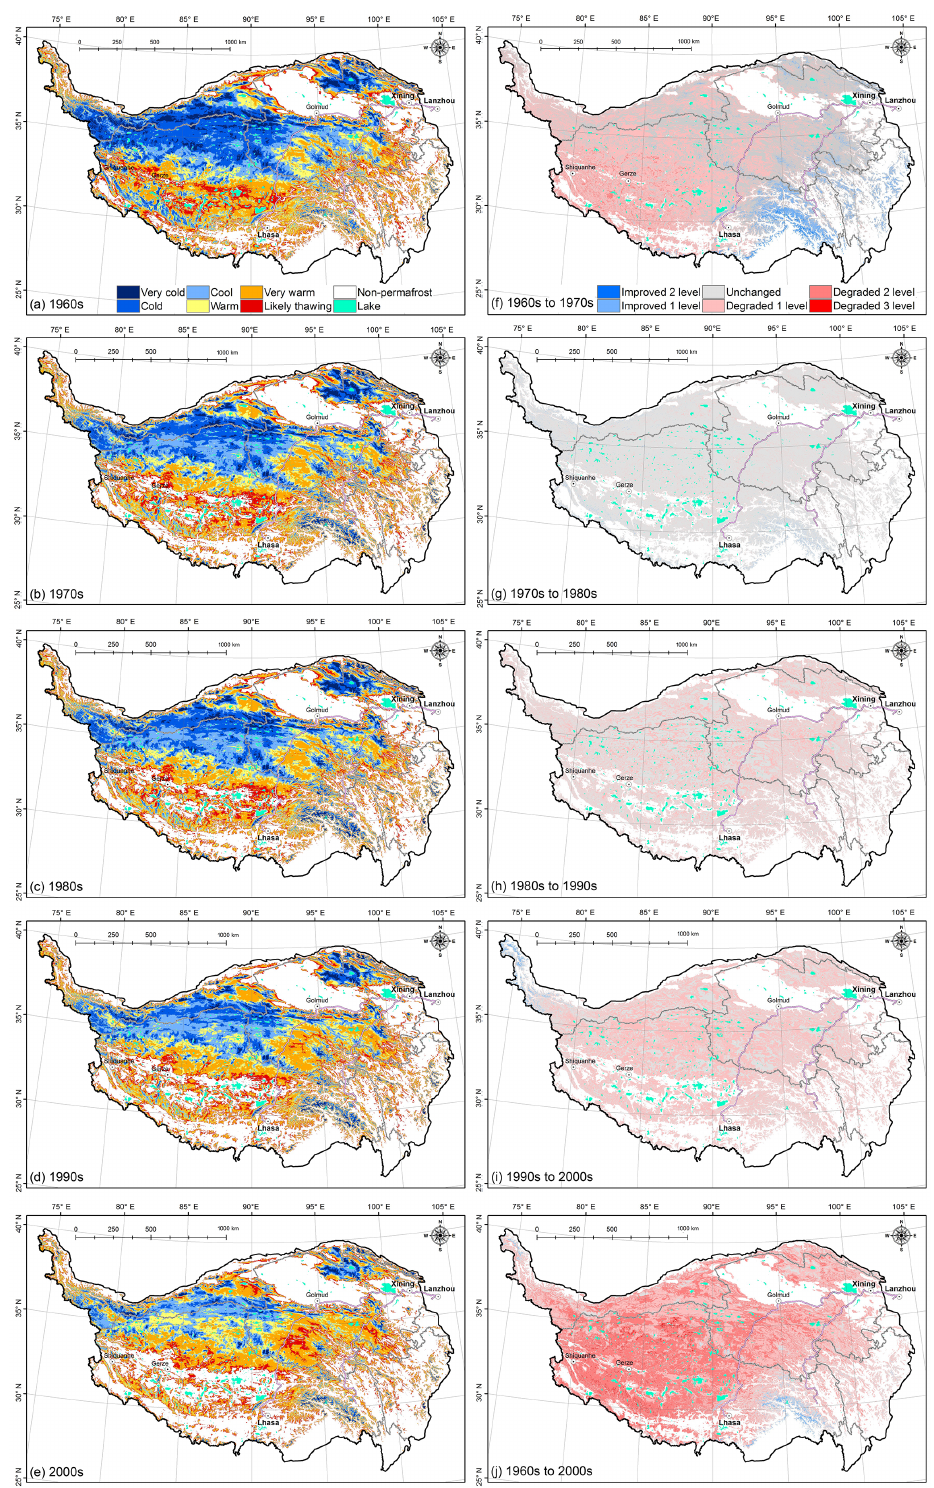
Figure 4. The permafrost map in each decade (a–e) and its spatial changes from the 1960s to the 2000s (f–j) over the QTP during the past